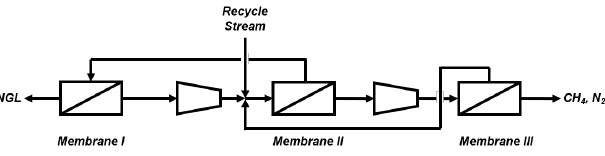
Figure A2. Cascade gas membrane demethanizer